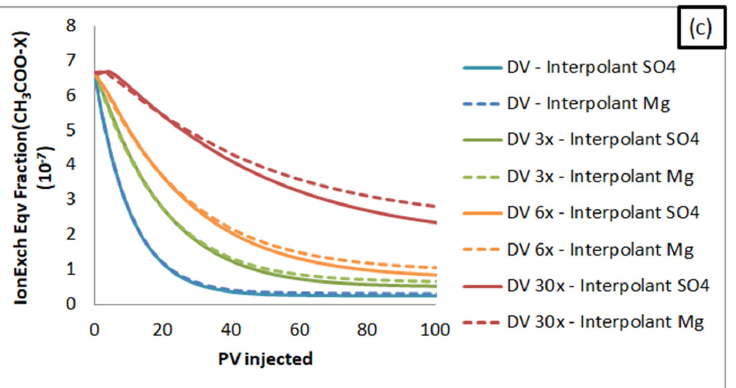
Figure 10. Ion Exchange Equivalent Fraction (CH 3 COO-X) variation in the grid block {1,1,1} for brine injection: ( a ) STD; ( b ) MV and ( c ) DV.